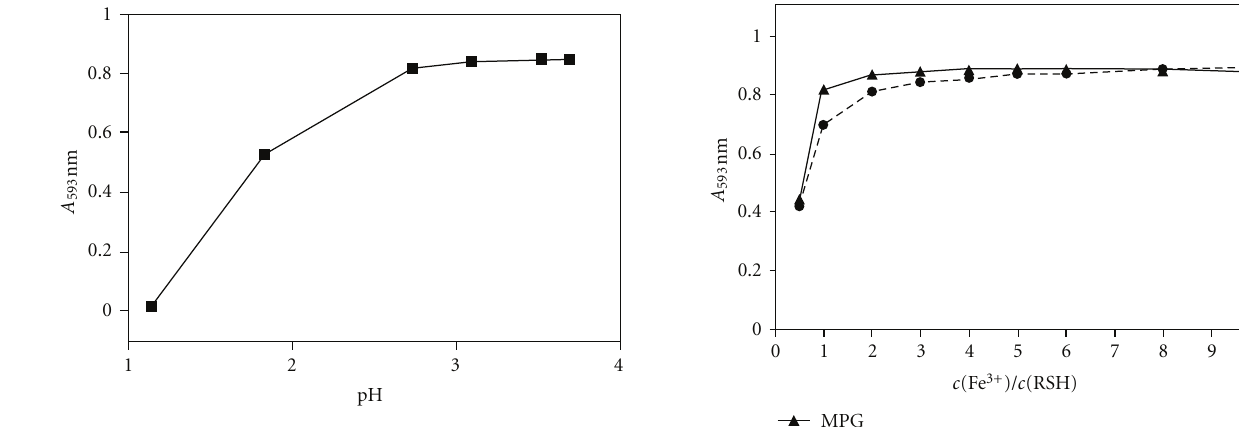
Figure 1: E ff ect of the pH value of the reaction mixture on the absorbance of the Fe(TPTZ) 22+ complex. For each pH value, the absorbance was recorded 30 minutes after beginning of the reaction. Triplicate measurements, practically the same, were done for each pH value. Initial concentrations were 40 μ M for MPG, 0.2 mM for Fe(III), and 0.2 mM for TPTZ. Reaction temperature was 25 ◦ C.